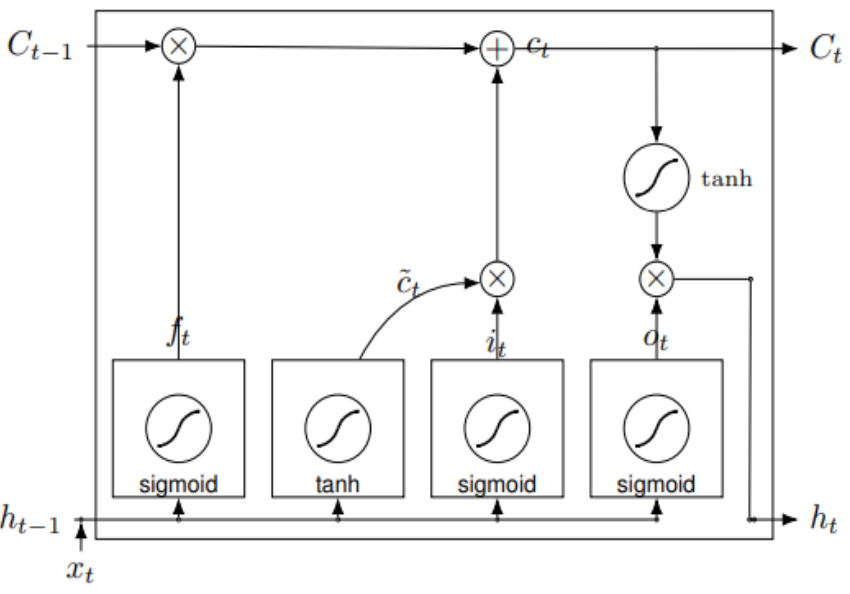
Figure 6. Cell structure of Bi-LSTM. Source: [17].